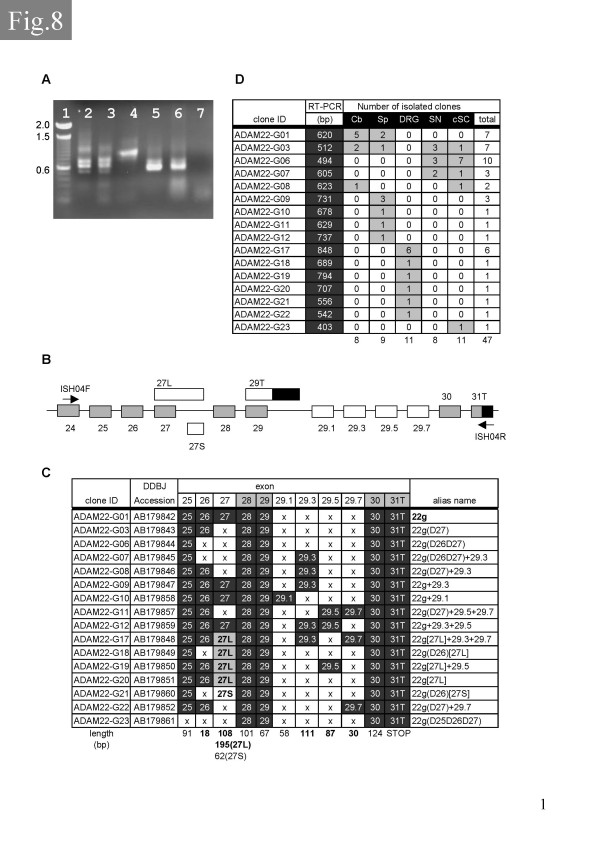
Adam22 gene structure and tissue specific transcripts. (A) RT-PCR analysis. Amplified DNA fragments were analysed by 1 % agarose gel electrophoresis. Lanes 1. 100 bp DNA ladder; 2. cerebellum; 3. spinal cord; 4. dorsal root ganglion; 5. sciatic nerve; 6. cultured Schwann cells; 7. distilled water (B) Exon organization of the mouse Adam22 gene is illustrated. Boxes indicate exons. The G01 transcript (orthologous to the human ADAM22 isoform 1 transcript) is composed of grey boxes. Boxes in black indicate non-coding region. (C) Summary of the isolated clones. The nucleotide sequence data have been deposited with the DDBJ/EMBL/GenBank Data Libraries under the accession numbers described in the table. (D) Number of clones isolated from each tissue is summarized. Cb; cerebellum, Sp; spinal cord, DRG; dorsal root ganglion, SN; sciatic nerve, cSC; cultured Schwann cells.